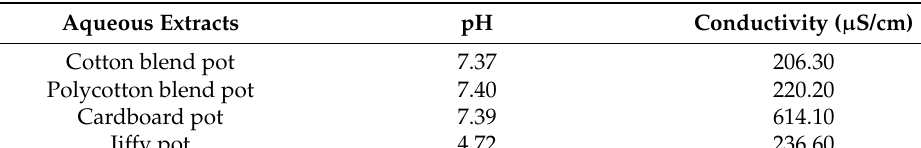
Table 3. pH and conductivity of aqueous extracts from studied pots.